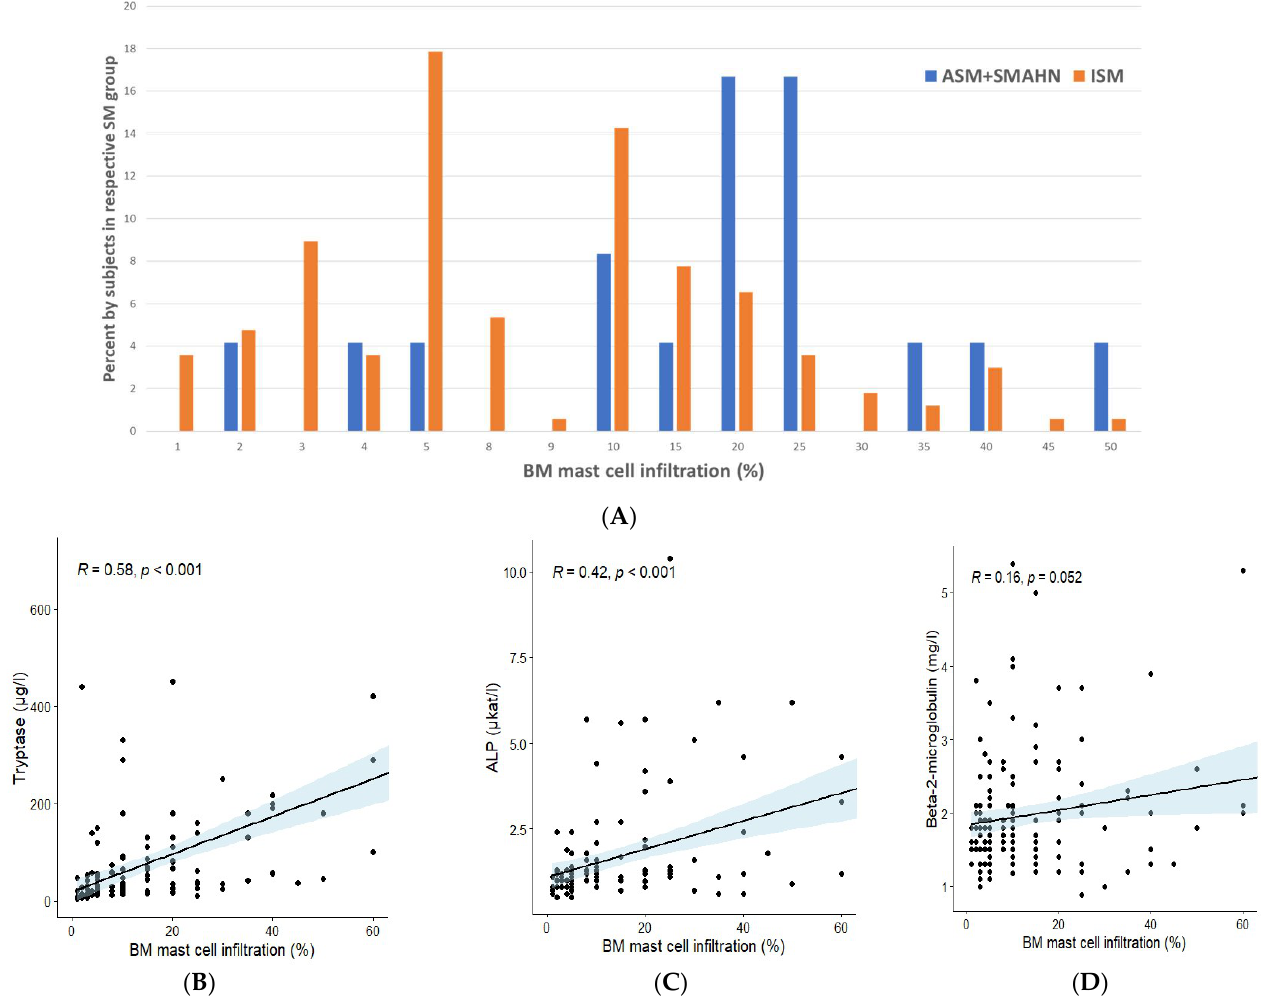
Figure 1. Different aspects of bone marrow mast cell infiltration in different SM variants: ( A ) percentage of bone marrow mast cell infiltration in different SM variants; correlations between bone marrow mast cell infiltration (%) and ( B ) tryptase, ( C ) ALP, and ( D ) B2M were assessed using Spearman’s rank correlation test. Abbreviations: SM, systemic mastocytosis; ALP, alkaline phosphatase; B2M, beta-2-microglobulin.